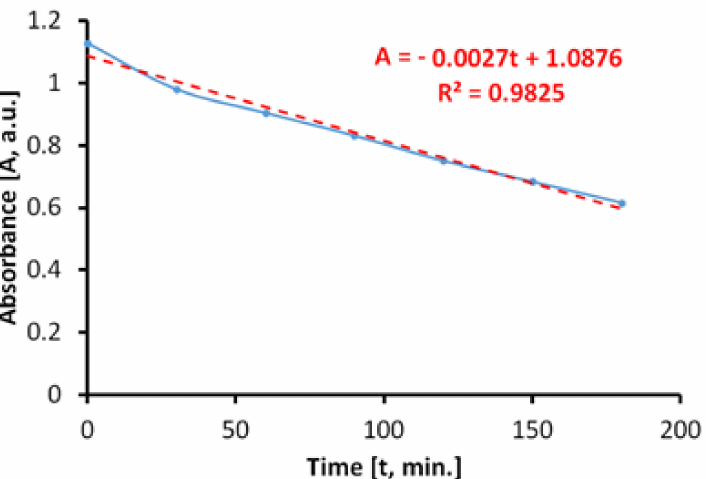
Figure 15. Time variation of MB solution absorbance by irradiating with arc-xenon light in the absence of the photocatalytic